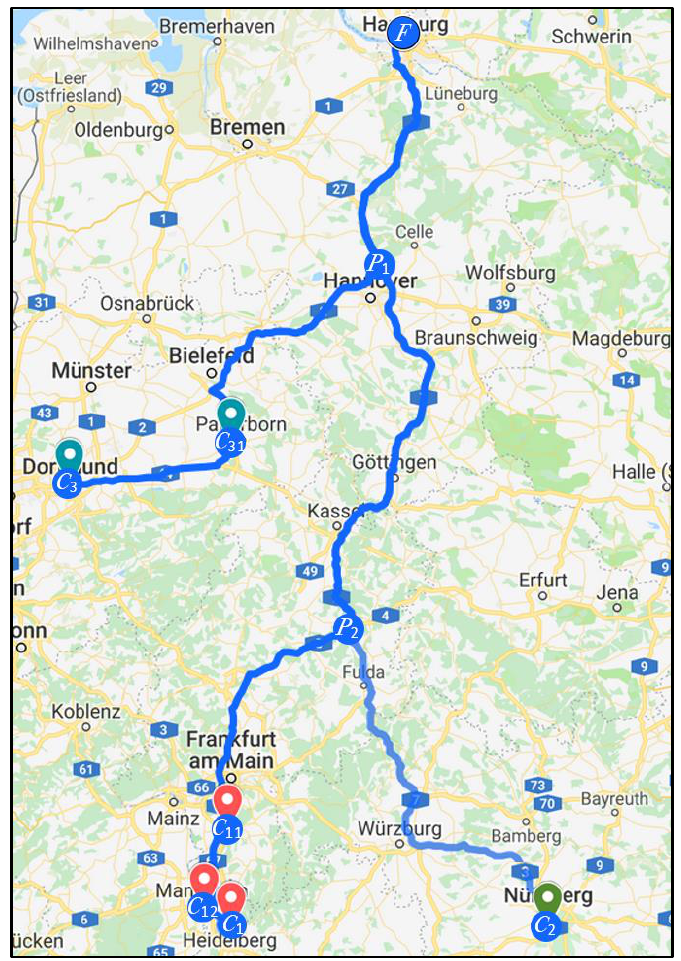
Figure 5. Present case situation.